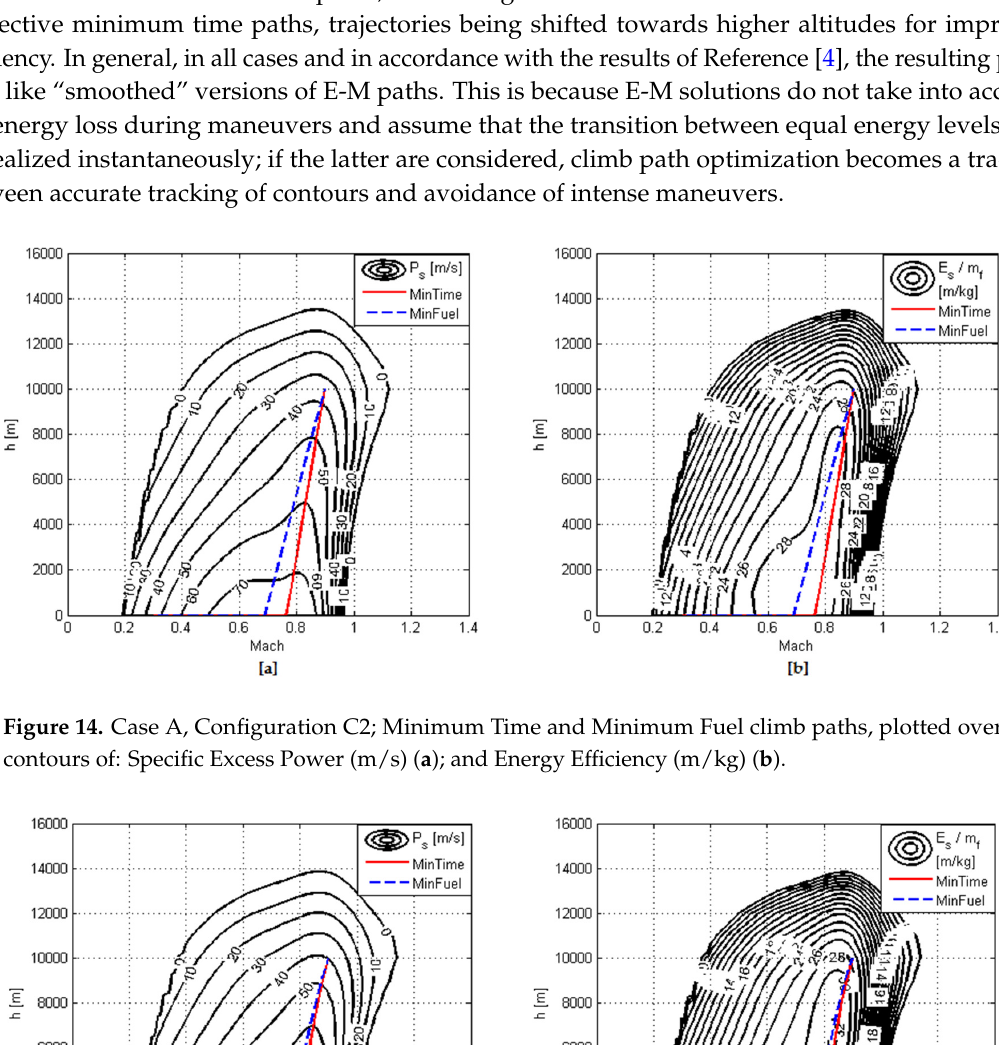
Figure 16. Case B; comparison of fronts of non-dominated solutions obtained for Configurations C1, C2 and C3.